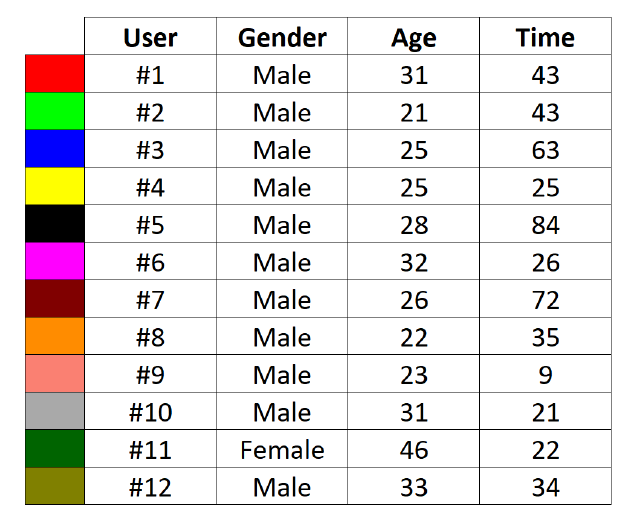
Figure 16. Profile of the 12 users that participated on the tests. The colors will be used to identify them in Figure 17.